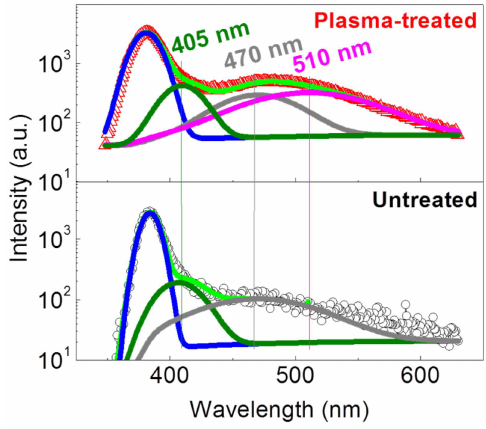
Figure 8. Room-temperature photoluminescence (PL) spectra of the ZnO NWs and their Gaussian